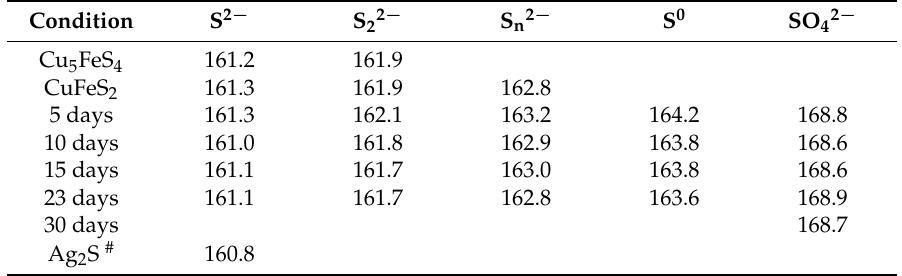
Table 2. Binding energy values for X-ray photoelectron spectroscopy (XPS) spectra of S 2p 3/2 peaks (eV).